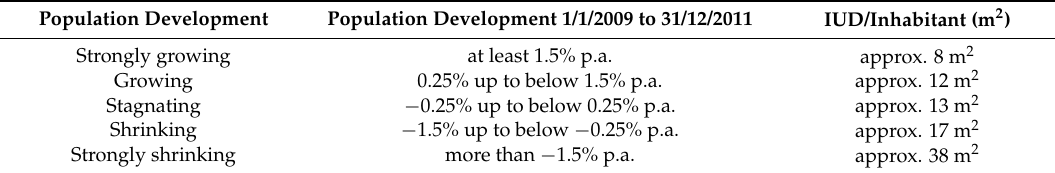
Table 2. Inner-urban development potential per inhabitant classified by population